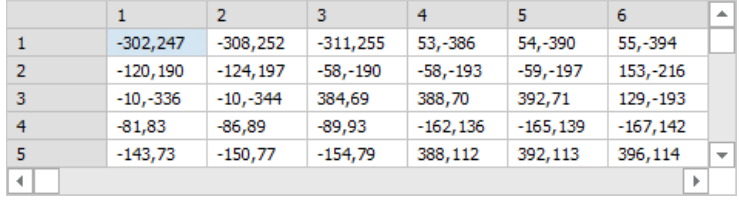
Figure 2. Two - dimensional matrix—points by frames (for stimulus cl201.bin). Figure 2. Two-dimensional matrix—points by frames (for stimulus